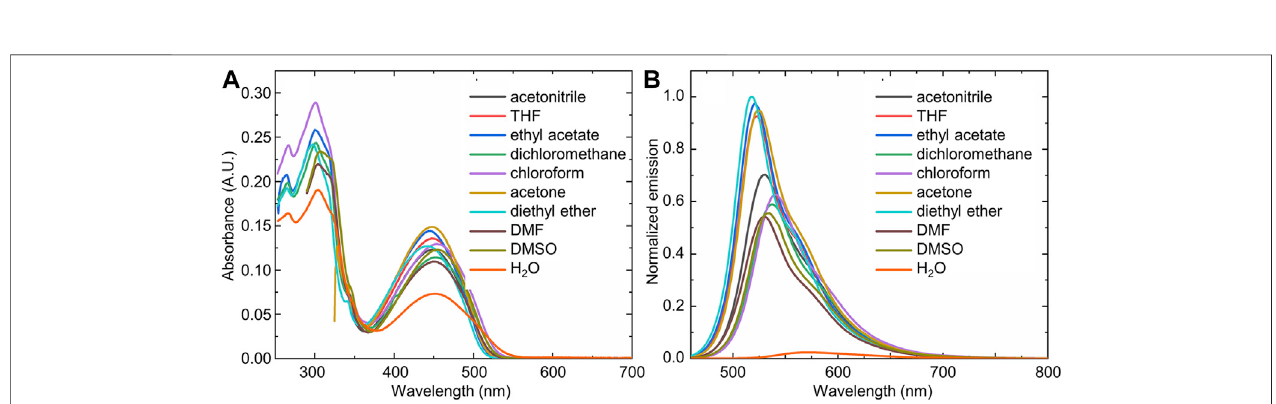
FIGURE2| The (A) UV-visibleand (B) fl uorescenceemissionspectraofcompound 1 inavarietyofsolvents,highlightingthemarkeddifferenceinspectraobserved in water (orange trace) compared to the organic solvents [( 1 ) (cid:1) 10 μ M; λ ex (cid:1) 450 nm].